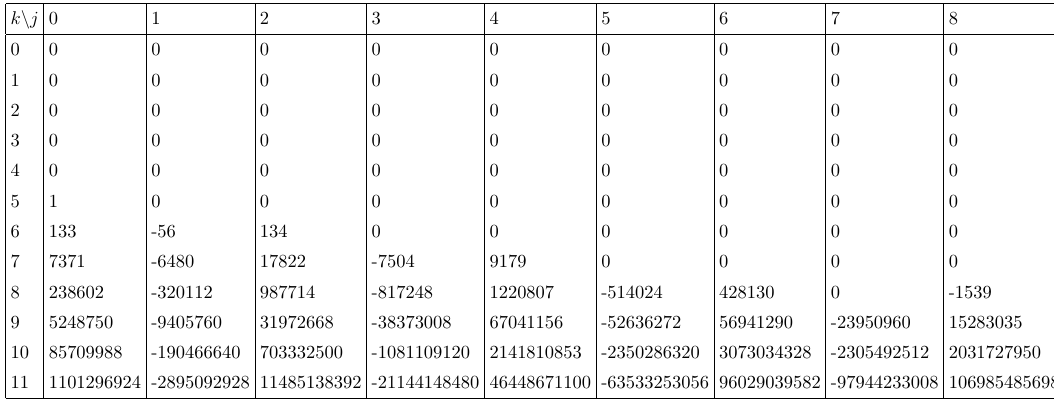
Table 88. Table of b jk coe(cid:14)cients for h E 7